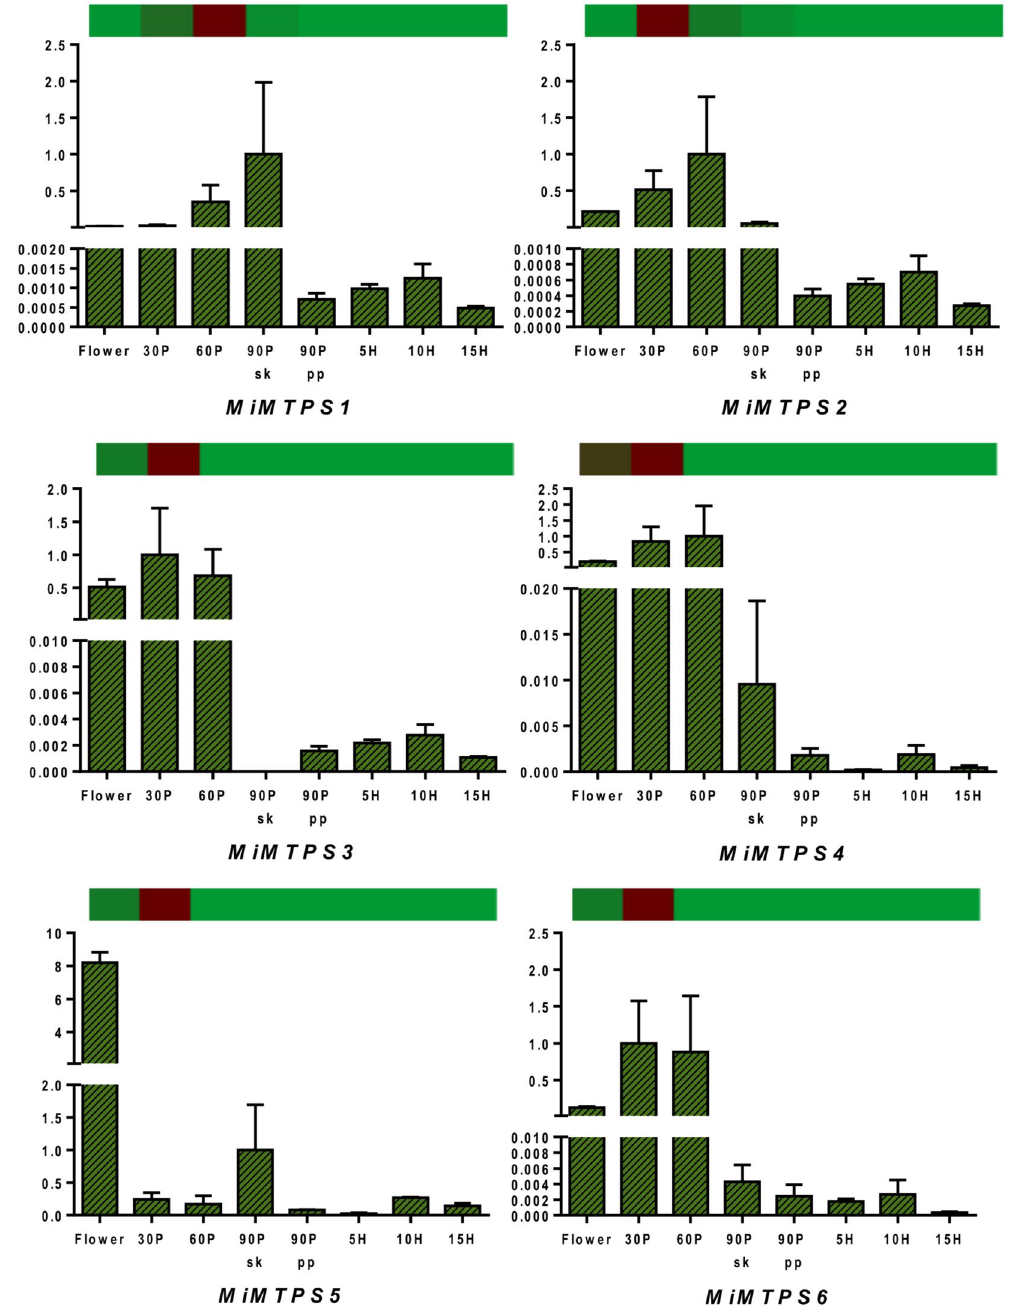
Figure 8. Quantitative reverse-transcriptase PCR validation of various transcripts obtained through RNAseq from mono-terpene metabolism through various tissues (flower and fruit developing and ripening stages). Vertical bars at each data point represent standard error in the relative quantification among the three biological replicates. X-axis represents fruit development and ripening stages and Y-axis represents relative transcript abundance. The horizontal bar above each histogram represents the expression level of the same transcript as obtained through RNAseq analysis, wherein dark-red color indicates higher expression and light-green color indicates lower expression. Gene names are as referred in result section “Transcriptome validation through qRT